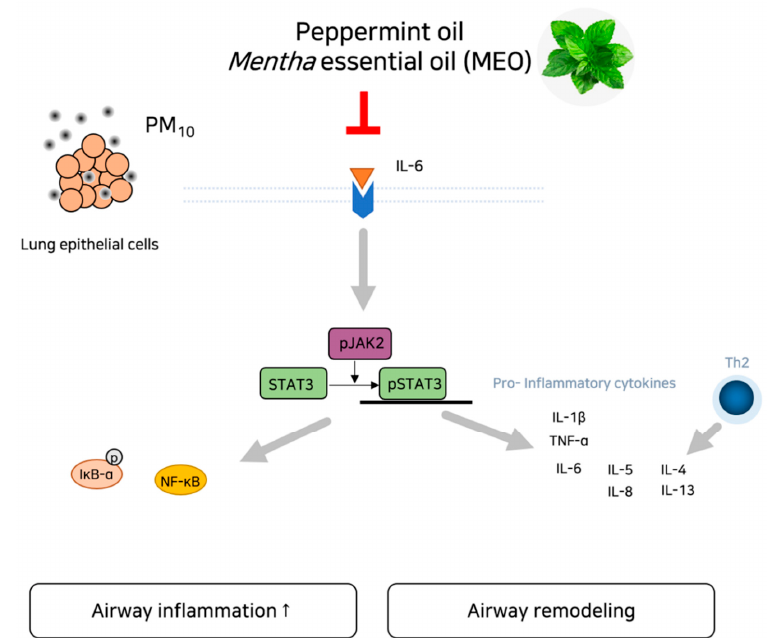
Figure 7. Schematic diagram of potential action of MEO on asthma under exposure of PM via inhibition of IL- 6/JAK2/STAT3 pathway.